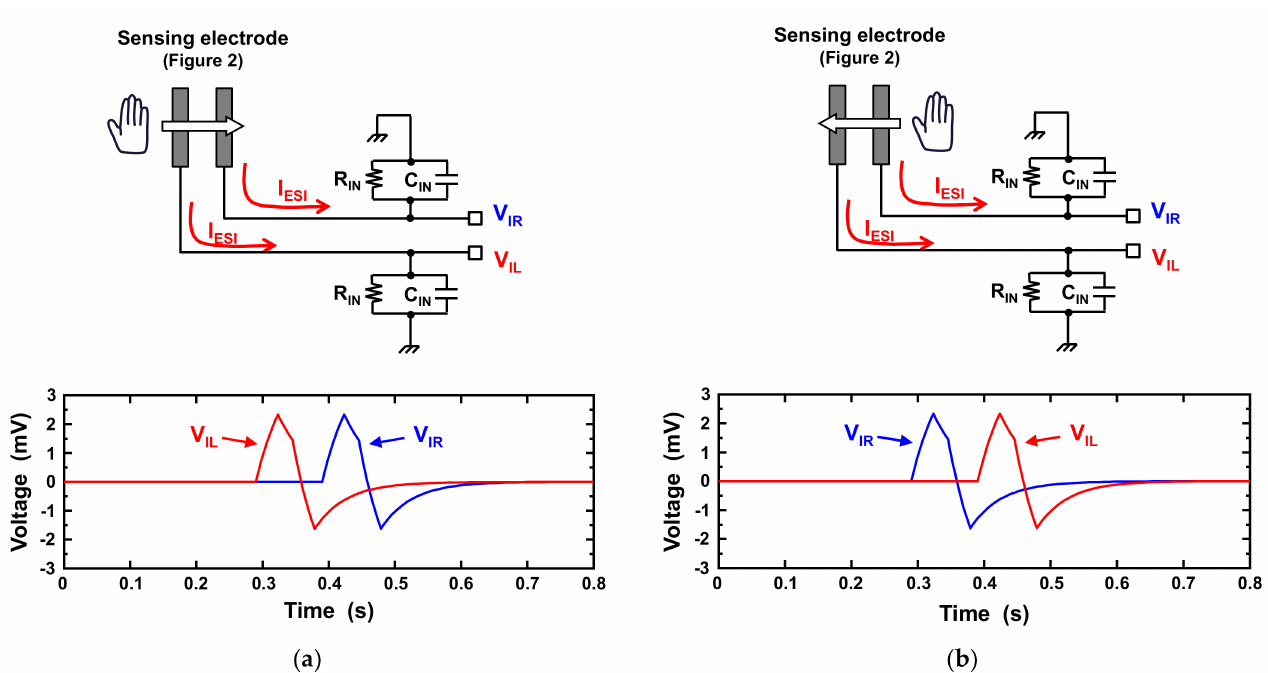
Figure 3. Mechanism of the proposed ESI-based gesture recognition technique. In the proposed technique, two electrodes with an electret are placed at a certain distance from each other. When the hand moves horizontally over the electrode, the ESI current I ESI is generated, which induces the voltage change in V IL and V IR . ( a ) When the hand moves from left to right, V IL changes earlier than V IR . ( b ) When the hand moves from right to left, V IR changes earlier than V IL . This means that gestures can be recognized by observing the ESI currents ( I ESI ) induced in the two